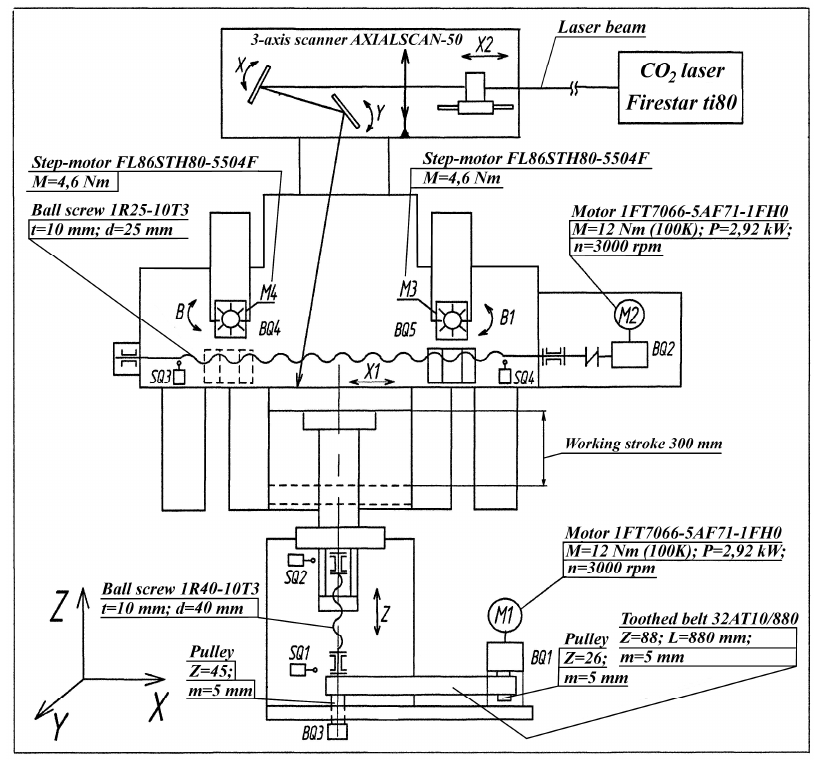
Figure 4. Kinematic scheme of the SLS machine: M1, M2, M3, M4—electric motors; X, Y—axes of the main movements; Z, X1, B, B1, X2—axes of auxiliary movements; SQ1, SQ2, SQ3, SQ4—endpoint sensors; BQ1, BQ2, BQ3, BQ4—position control sensors.